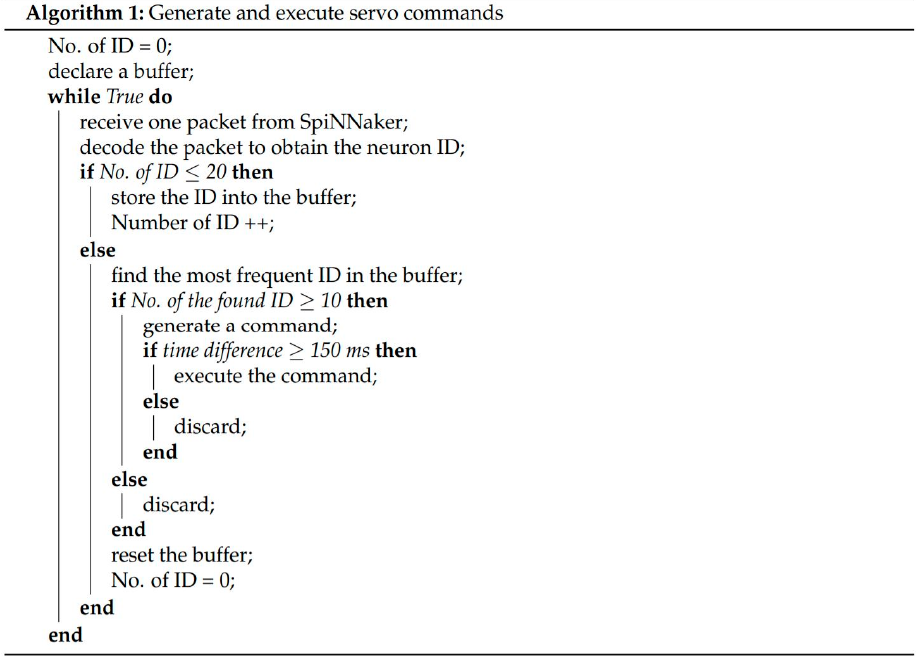
Figure 4. The algorithm/pseudo-code above is used to generate and execute servo commands.